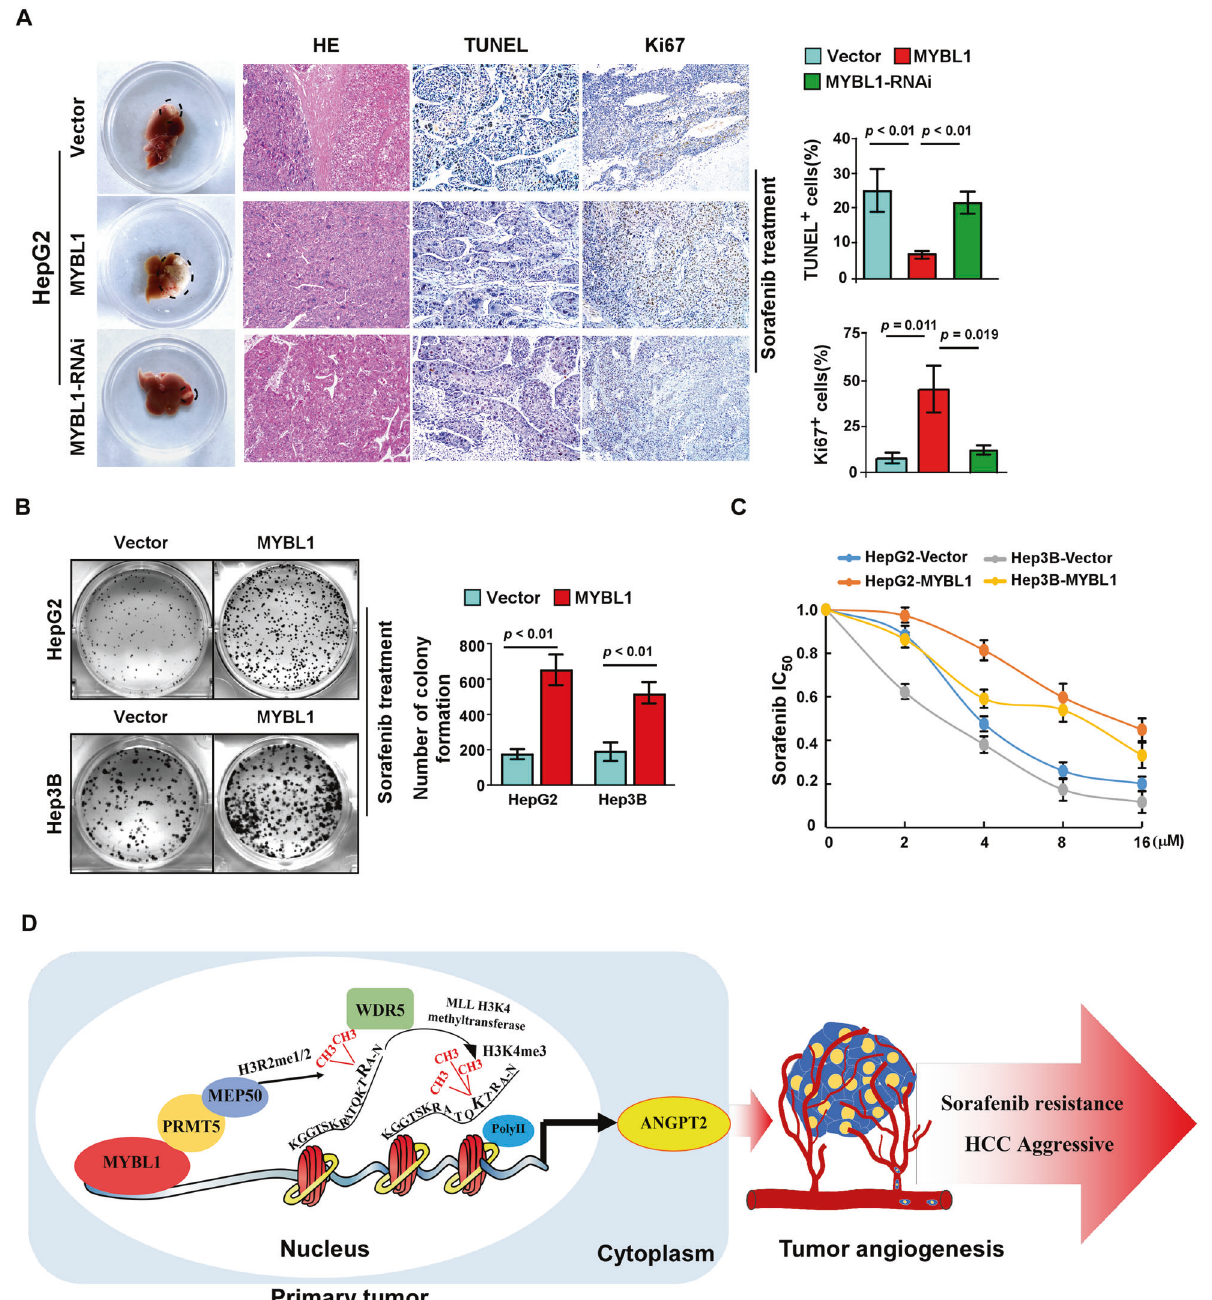
Fig. 8 MYBL1 overexpression confers sorafenib resistance to HCC cells. A Representative tumor images from liver (left); IHC staining indicating the Tunel and Ki67 protein expression in the indicated group (middle); quanti fi cation of Tunel and Ki67 protein expression in the indicated group(right). B Representative micrographs (left) and quanti fi cation (right) of colony formation of HCC cells. C IC50 of sorafenib in the indicated cells. D Schematic diagram illustrating that MYBL1 induces transcriptional expression of ANGPT2 to promote tumor angiogenesis and confer sorafenib resistance in human hepatocellular with distant metastasis in HCC, suggesting that upregulation of MYBL1 might contribute to the malignant potential of HCC. We found that overexpression of MYBL1 dramatically enhanced, whereas downregulation of MYBL1 reduced angiogenesis in HCC. Therefore, our results suggest that MYBL1 functions as a critical pro-angiogenic factor in HCC by performing both in vitro and in vivo approaches, and that MYBL1 may represent a novel prognostic biomarker and anti-angiogenesis target for HCC patients.